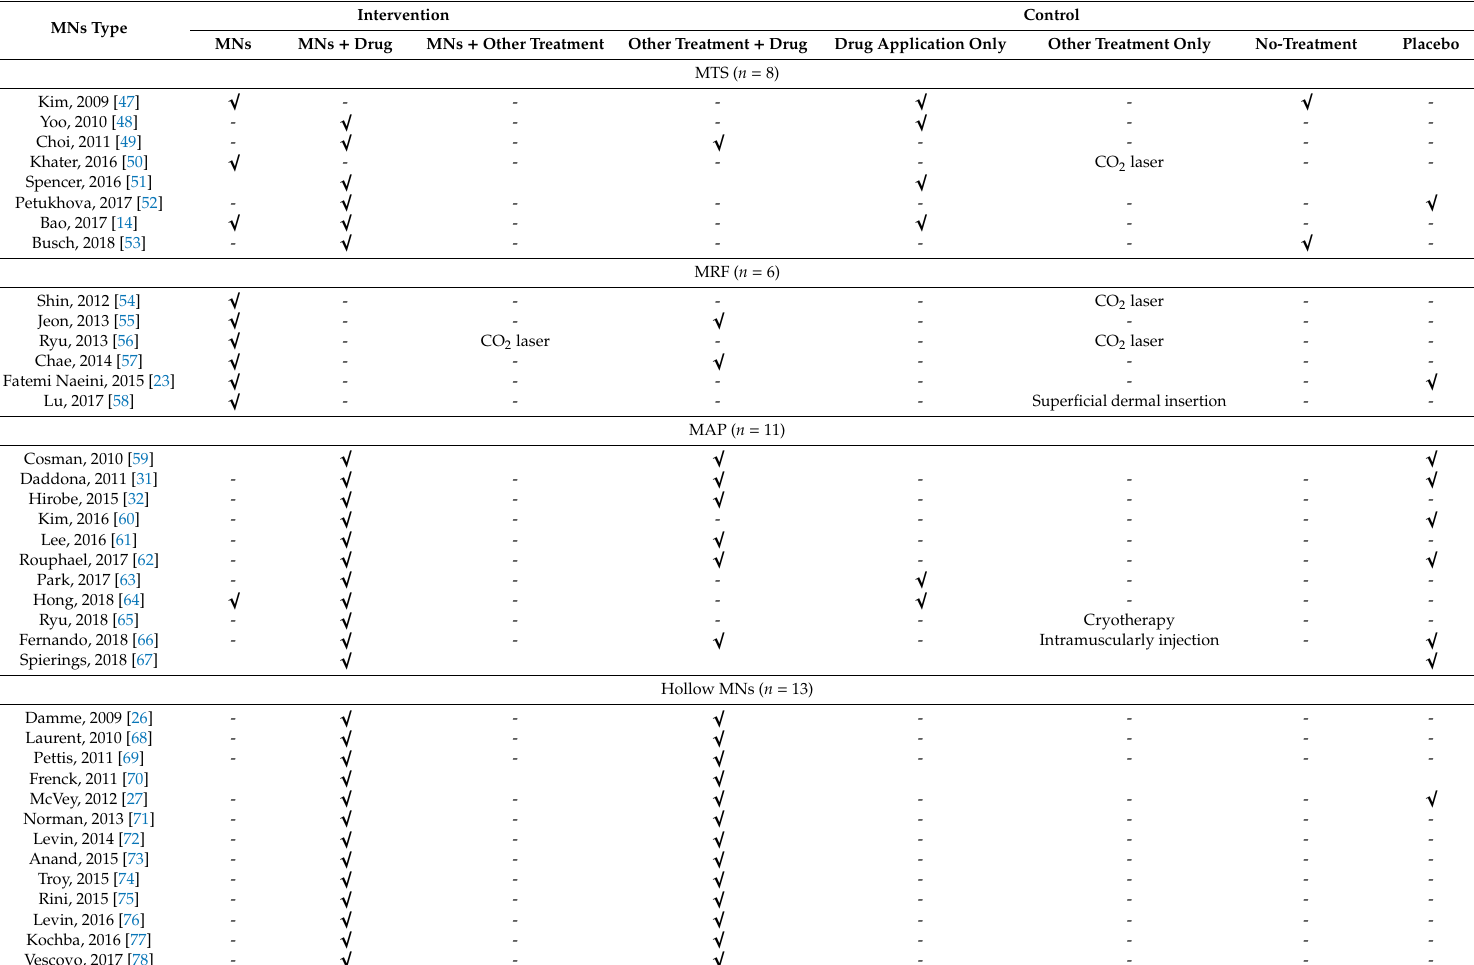
Table 1. Summary of the intervention and